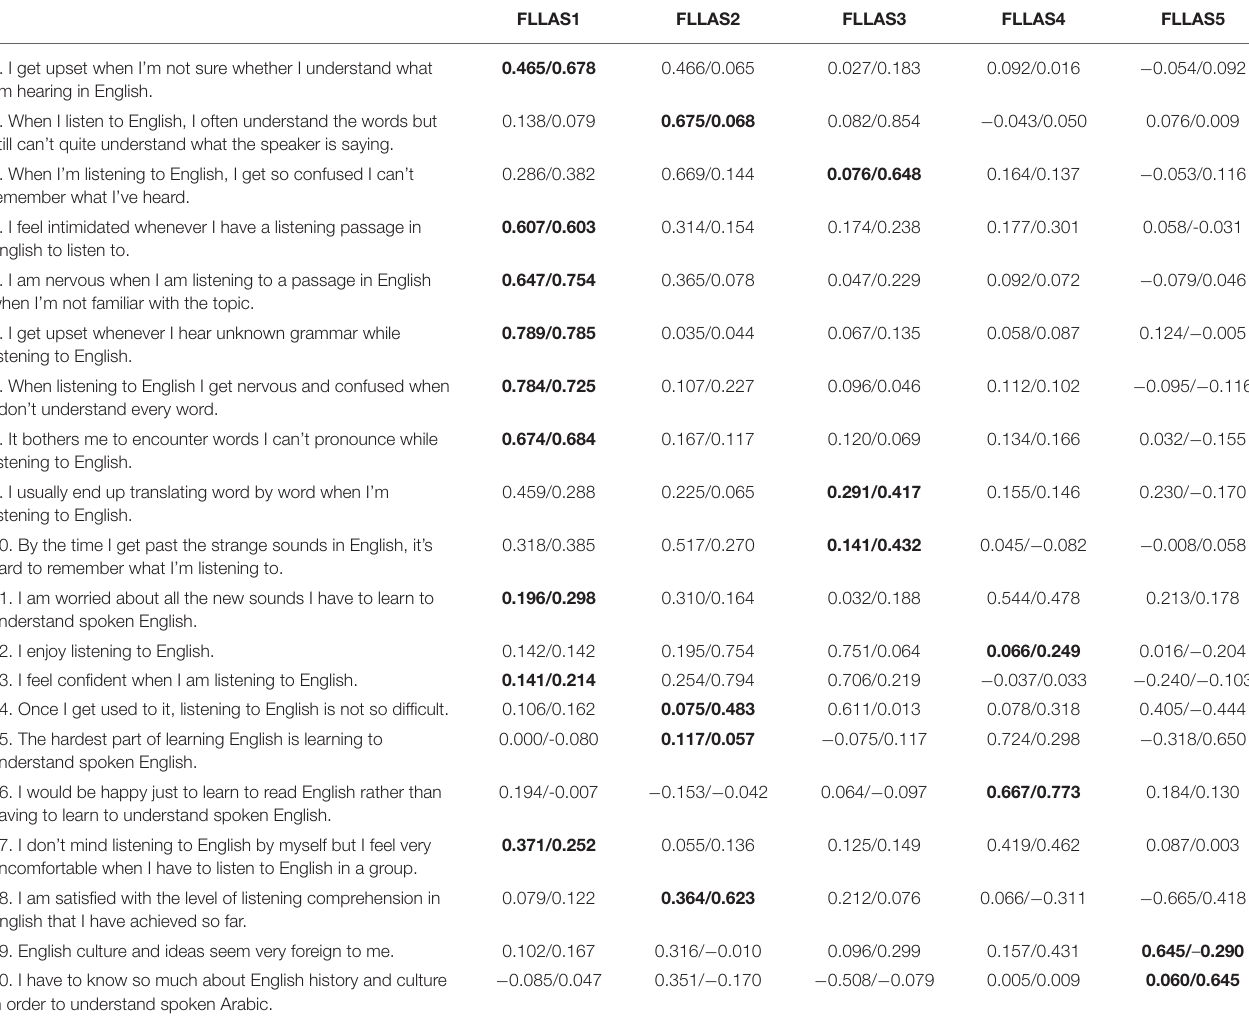
TABLE 1 | Loadings of Principal Components of FLLAS in Study 1 and Study